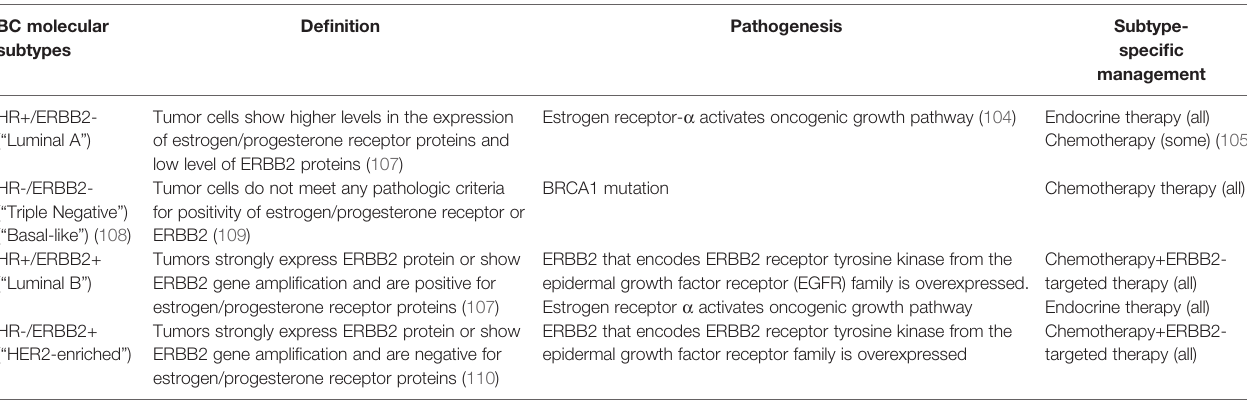
TABLE 1 | Molecular subtypes of